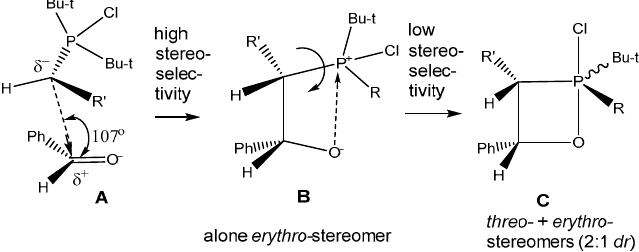
Scheme 22. Mechanism of asynchronous [2+2]-cycloaddition of P -chloroylide to benzaldehyde.